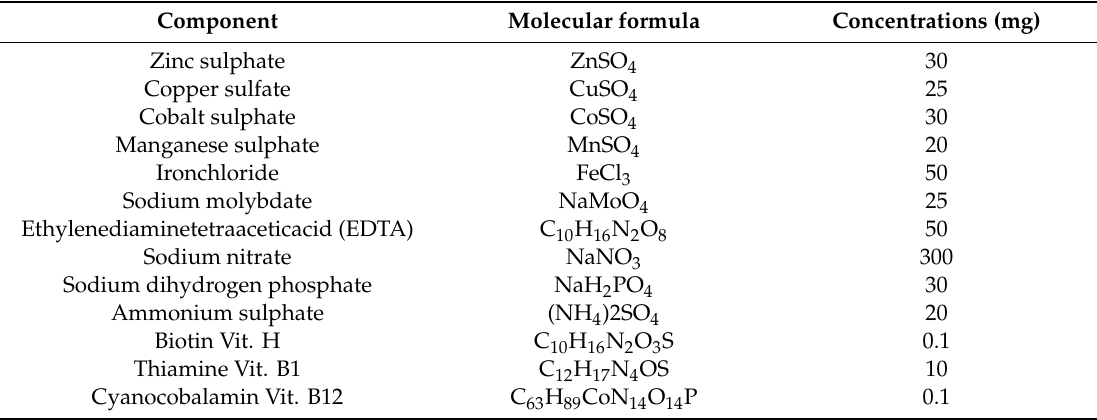
Table 7. Chemical composition of modified culture medium Guillard F / 2 was used as main nutrient source for marine